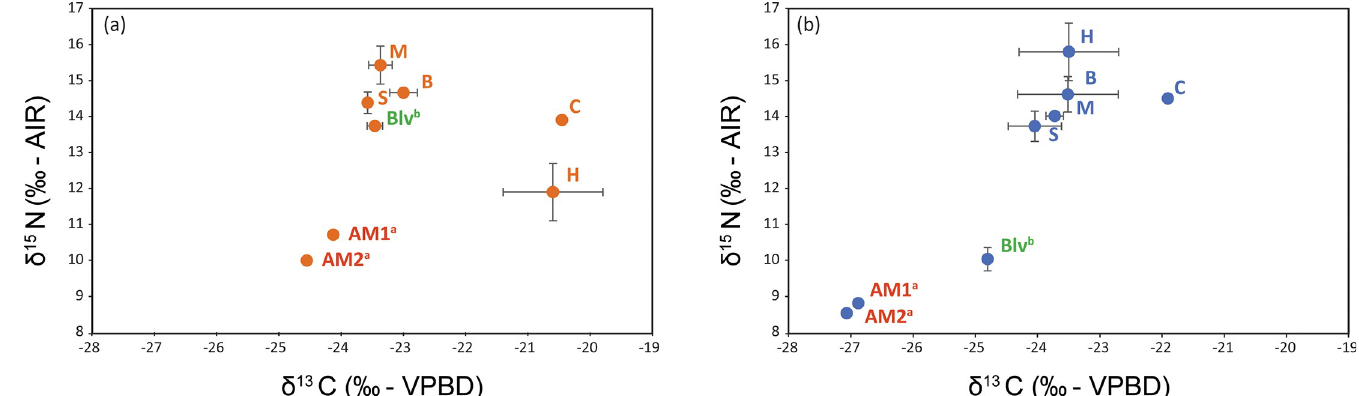
Fig 5. SIA biplots of adults P . macrosturtensis (B), P . mesosturtensis (M), P . microsturtensis (S), P . macrosturtensis larvae (Blv), S . axfordi (AM1), Y . sturtensis (AM2), Cyclopoida sp. (C) and Harpacticoida sp. (H) under low rainfall (a) and high rainfall (b). AM1 a and AM2 a (in red): taxa showing the biggest depletion in δ 13 C values for essential amino acids (phenylalanine and valine) across rainfall conditions; Blv b (in green): taxon showing the biggest drop in trophic position value (TP) between LR and HR. Refer to S3 Table for δ 13 C and δ 15 N values of the taxa.